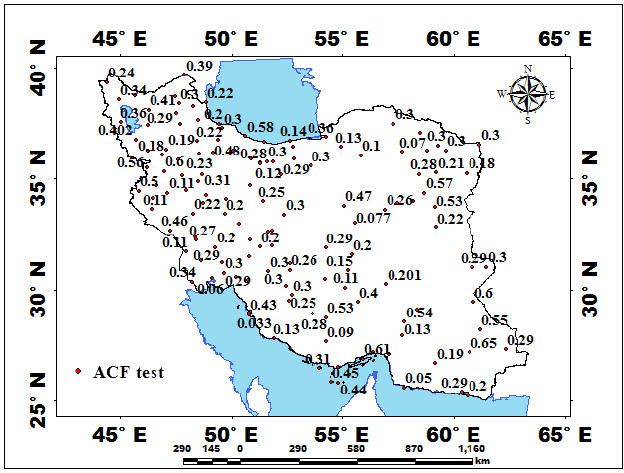
Figure 7. Values of the autocorrelation test.